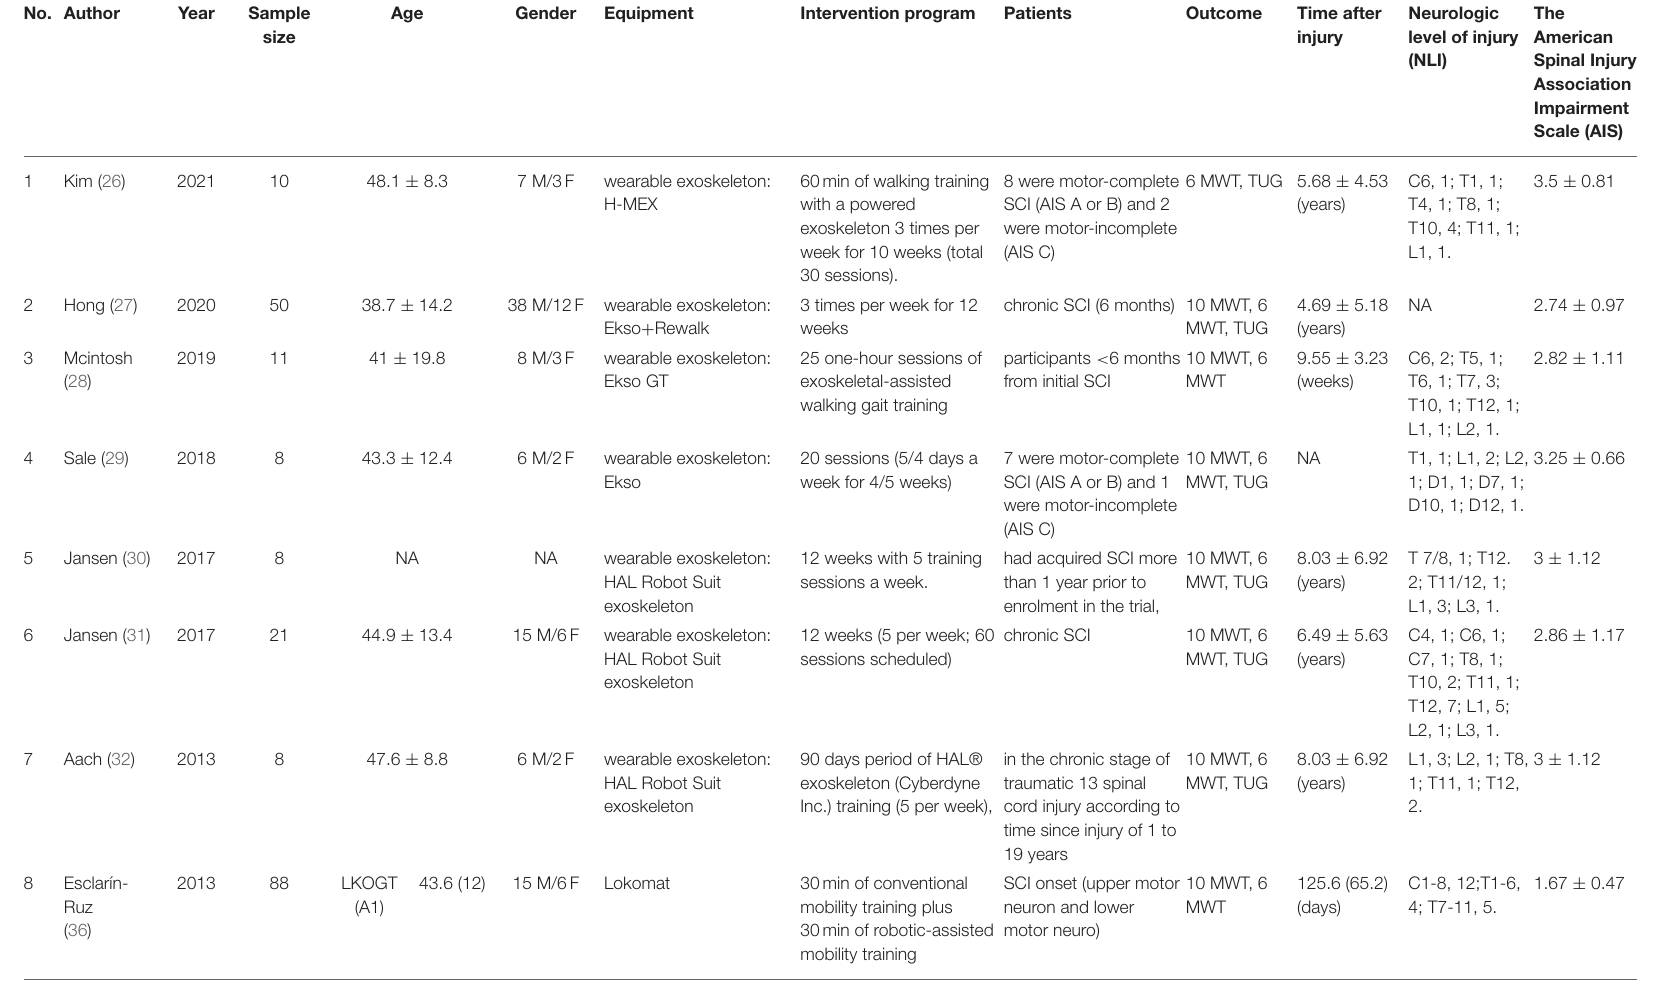
TABLE 1 | Characteristic of enrolled